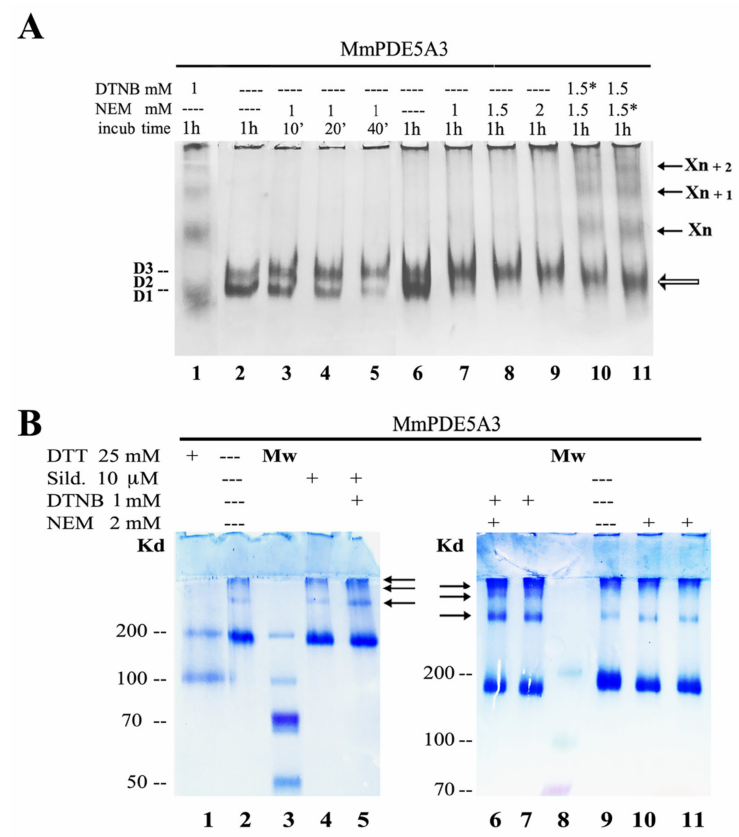
Figure 7. Effect of NEM on MmPDE5A3 visualized through native- and SDS-PAGE. ( A ) Migration of MmPDE5A3 on native gel in the presence of DTNB and NEM alone or in combination. The chemical marked with * was added 30 min after the other chemical. ( B ) Different migration of unboiled samples of MmPDE5A3 alone or after incubation with DTT, sildenafil, DTNB and NEM on denaturing, not reducing, SDS-PAGE. MW = molecular weight markers. The black arrows indicate the oligomers formed after incubation with DTNB (compatible with tetramers, hexamers and